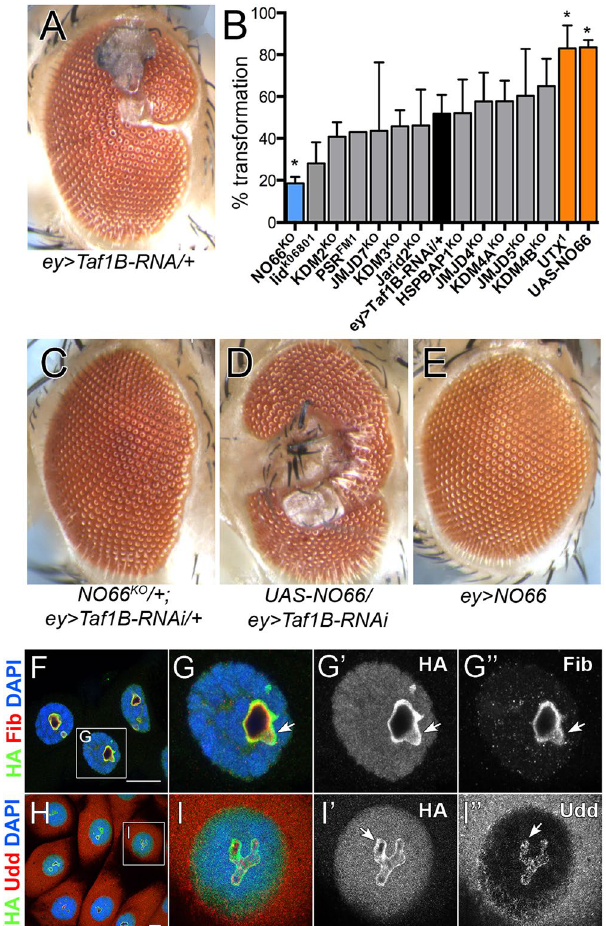
Figure 5. NO66 KO strongly modifies a growth phenotype in the eye. ( A , C – E ) Adult eyes of the indicated genotypes. ( A ) ey-Gal4 UASt-Taf1B-RNAi / + displays an eye to antenna transformation in ~35% of progeny. ( B ) A graph representing the number of eye to antenna transfomations in the genotypes ey > Taf1B-RNAi / + with JmjC KO / + , or UASp-NO66 . * P < 0.005. ( C ) NO66 KO / + suppresses the phenotype, and ( D ) UASp-NO66 enhances the phenotype, while ( E ) overexpression of NO66 alone has no phenotype. ( F , G” ) Salivary gland cells of the genomic tag NO66::HA stained with anti-HA (green, NO66), anti-Fib (red) and DAPI (blue), followed by single channels in greyscale. ( H , I” ) Salivary gland cells of the genomic tag NO66::HA stained with anti-HA (green, NO66), anti-Udd (red) and DAPI (blue), followed by single channels in greyscale. Scale bar is 20 μ